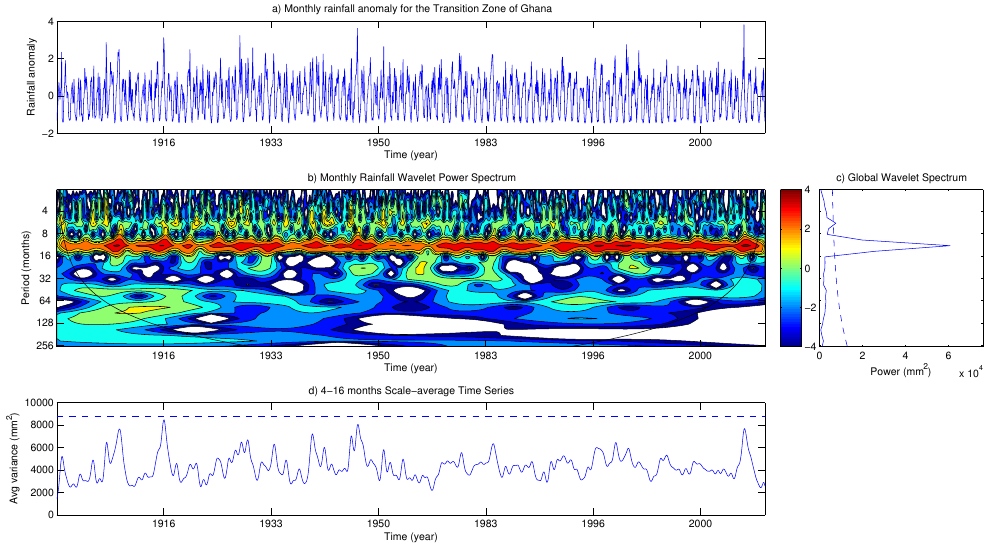
Figure 19. ( a ) Monthly Rainfall Anomaly in the Transition Zone for the 1901–2010 period. ( b ) Wavelet Power Spectrum for the Transition Zone. Cross-hatched region is the cone of influence; ( c ) The global wavelet power spectrum. The dashed line is the 5% significance level for the global wavelet spectrum; and ( d ) Scale-average wavelet power over the 4–16 months band. The dashed line is the 95%